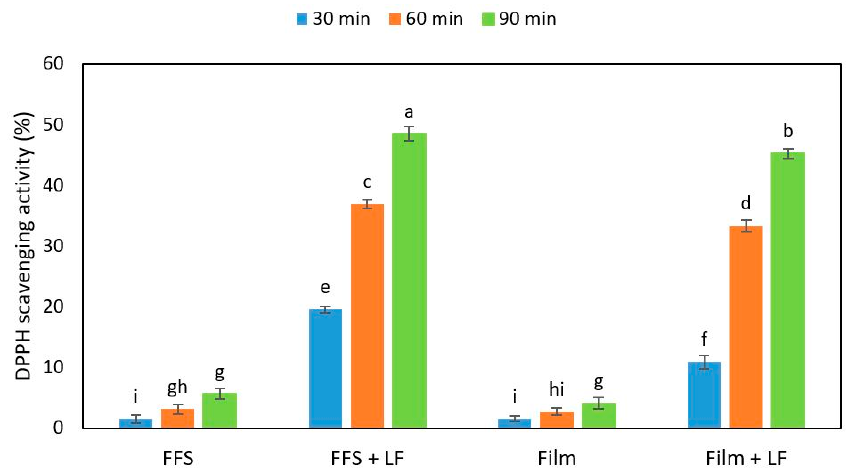
Figure 9. Antioxidant activity of hemp-protein-based film-forming solutions (FFSs) and films prepared in the absence or presence and of egagropili lignin fraction (LF) measured by 2,2-diphenyl-1-picrylhydrazyl (DPPH) assay at different times of incubation. Values with different small letters (a–i) were significantly different ( p < 0.05). Further experimental details were given in the text.